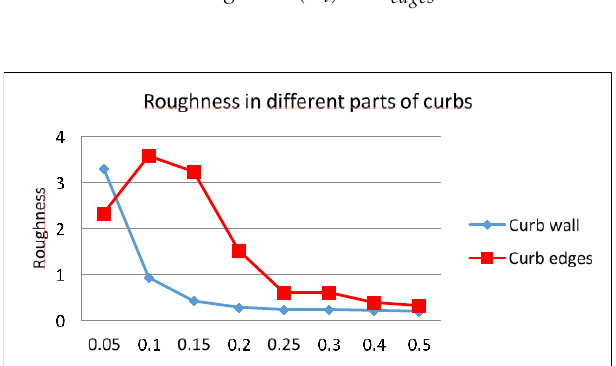
Figure 7. Roughness values in curb walls and curb edges ( vertical axis) for different neighborhood sizes ( horizontal axis, in cm).